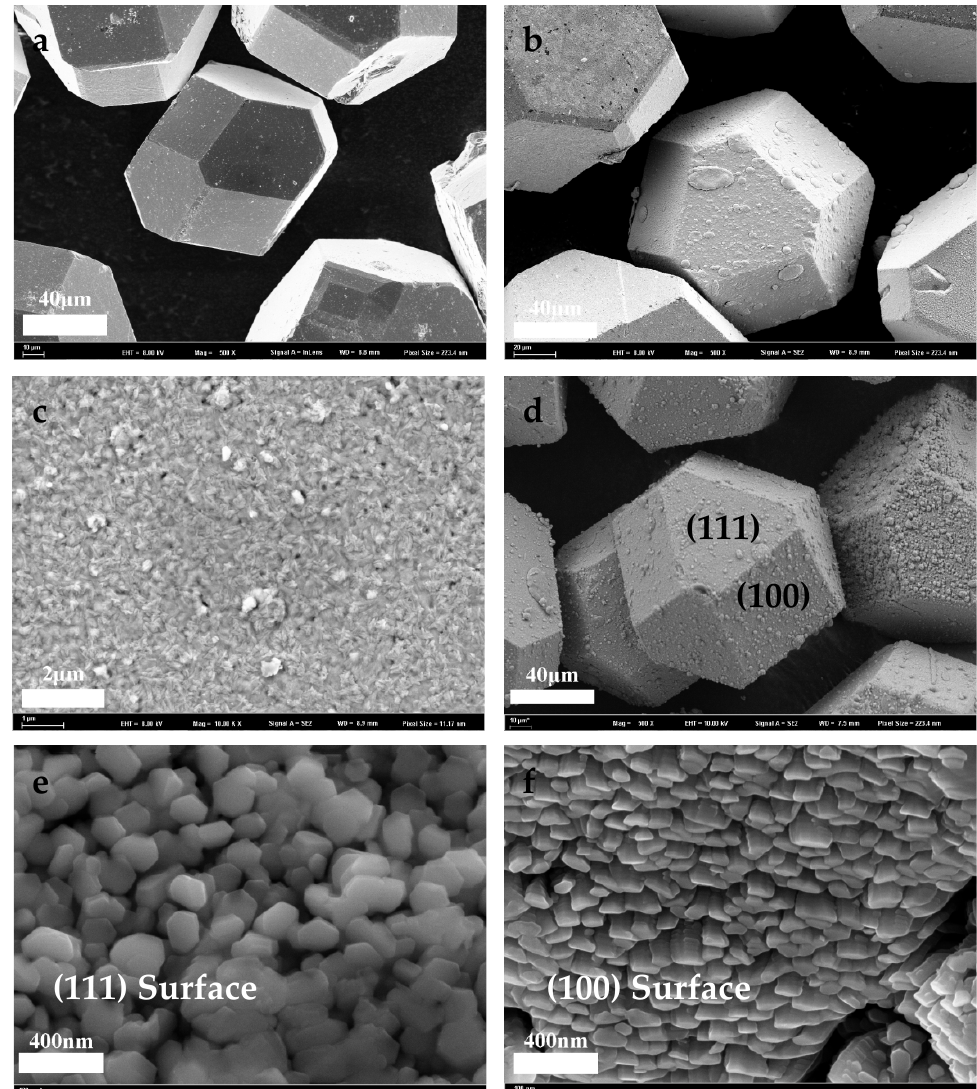
Figure 2. Scanning electron microscopy (SEM) images of the diamond particles: ( a ) uncoated diamond particles; ( b , c ) Cu-coated diamond particles; ( d ) Ti-coated diamond particles; ( e , f ) mor- phologies and orientations of Ti-coatings on diamond particles.